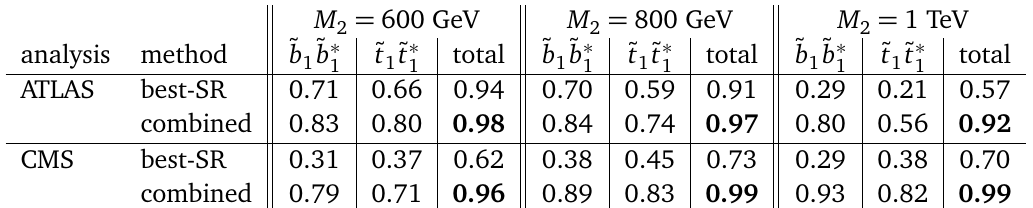
Table 2: 1 − CL values from the ATLAS (SUSY-2018-31) and CMS (SUS-19-006) s analyses without and with combining SRs, for M ˜ M ; the different columns compare sbottom production only (˜ b 2 ˜ t ∗ only (˜ t ), and sbottom + stop production taken together (total). Only if the total 1 1 production is considered and the SRs are combined we obtain 1 − CL